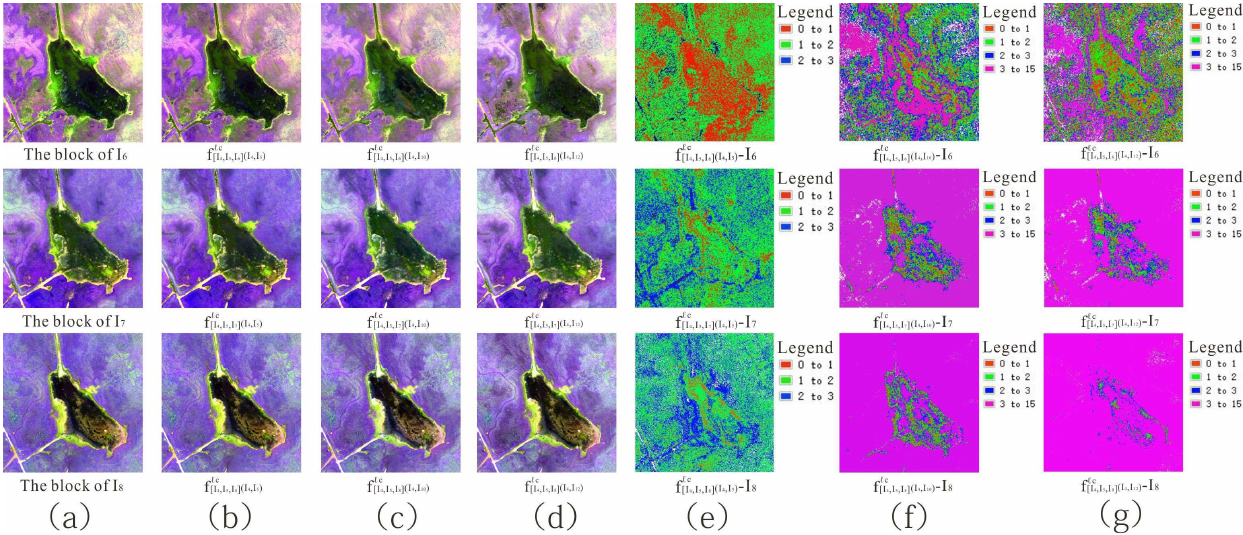
Figure 17. ( a ) Initial image ( b – d ) visual effect and ( e – g ) pixel error between block interpolated result and reference block using testing block pairs April–May, April–October, and April–December